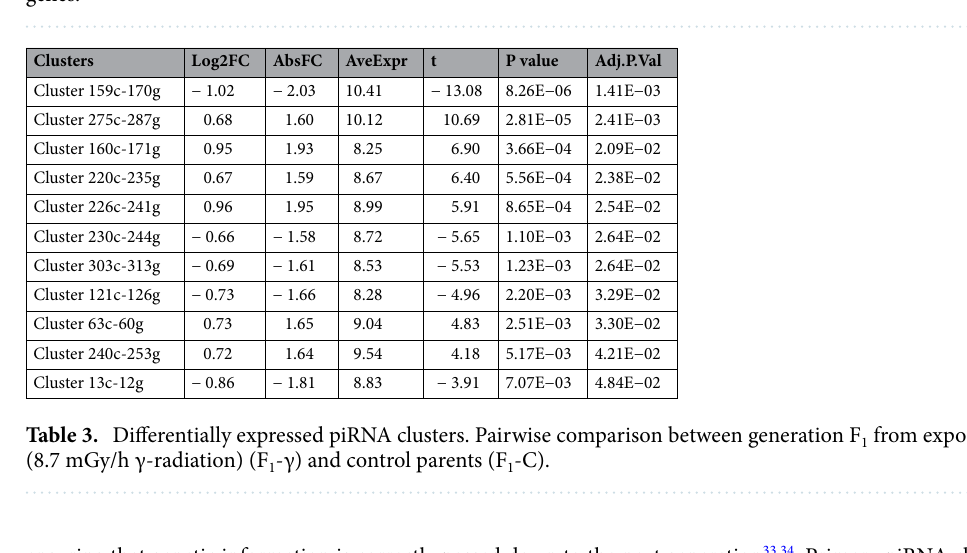
Figure 5. mRNA targets of let-7g involved in apoptosis network and showing the involvement of members of the miRNA biosynthesis pathway as well as other genes. This network predicts activation of apoptosis as shown by the orange edges between nodes. Arrowed blue lines predict inhibition. Green nodes indicate down-regulated genes.